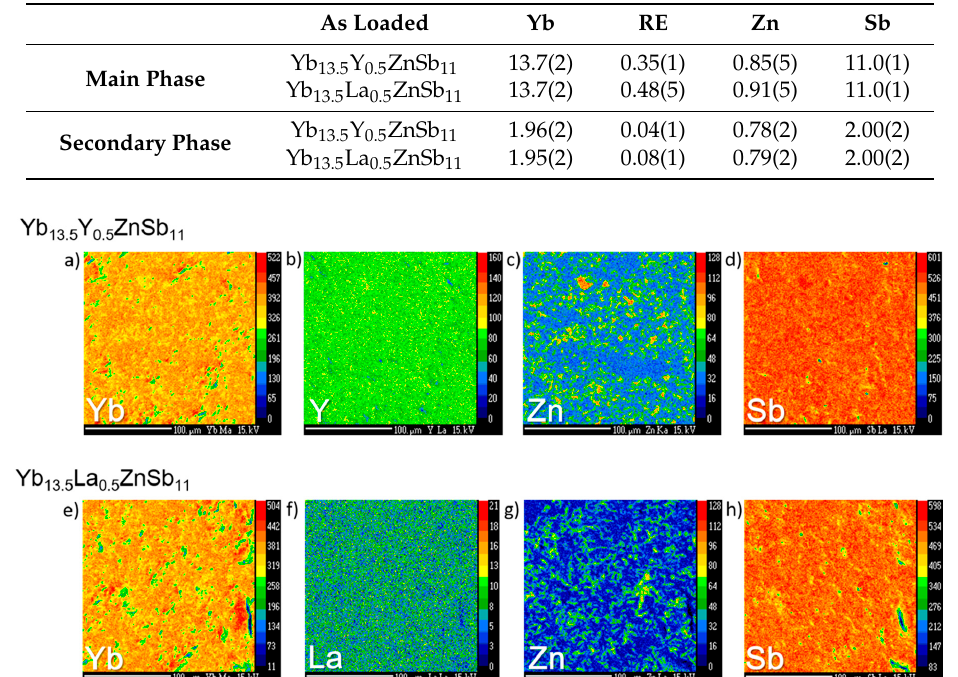
Figure 2. Electron microprobe X-ray maps of pelleted samples of Yb 13.5 Y 0.5 ZnSb 11 ( a – d ) and Yb 13.5 La 0.5 ZnSb 11 ( e – h ).